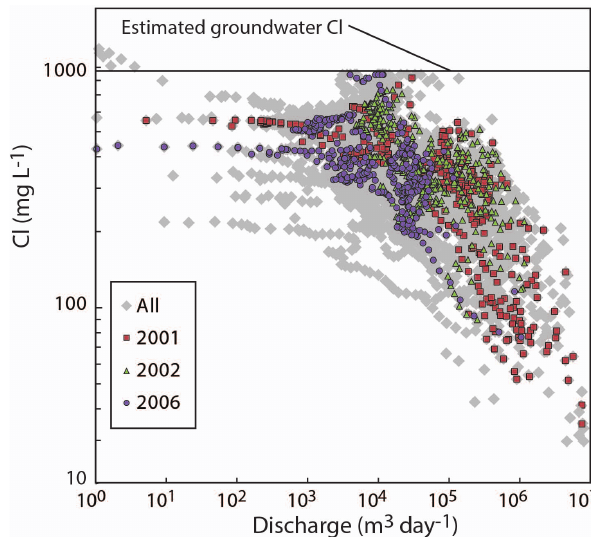
Fig. 7. Cl concentrations vs. discharge for the upper Barwon River between 2001 and 2011. Data from Water Resources Data Warehouse